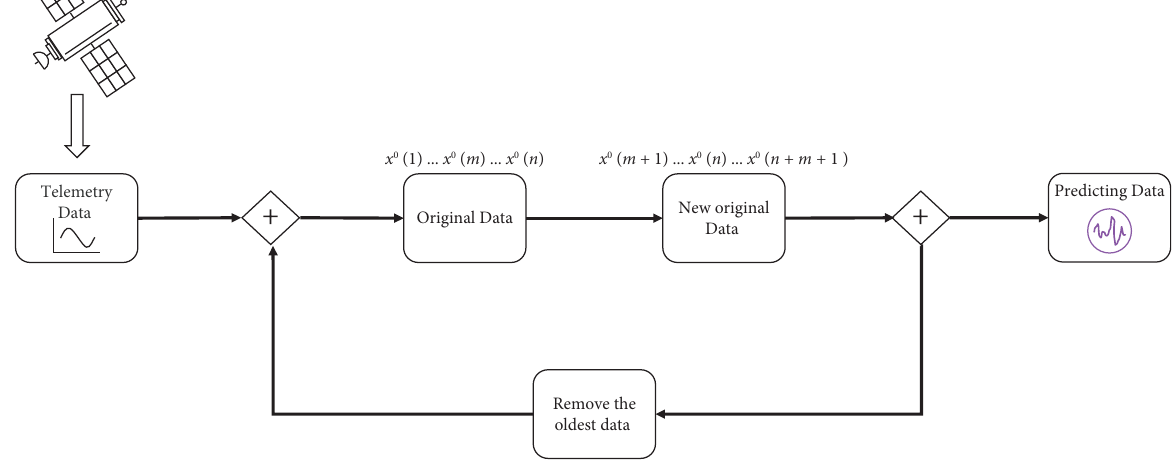
Figure 1: Sliding window